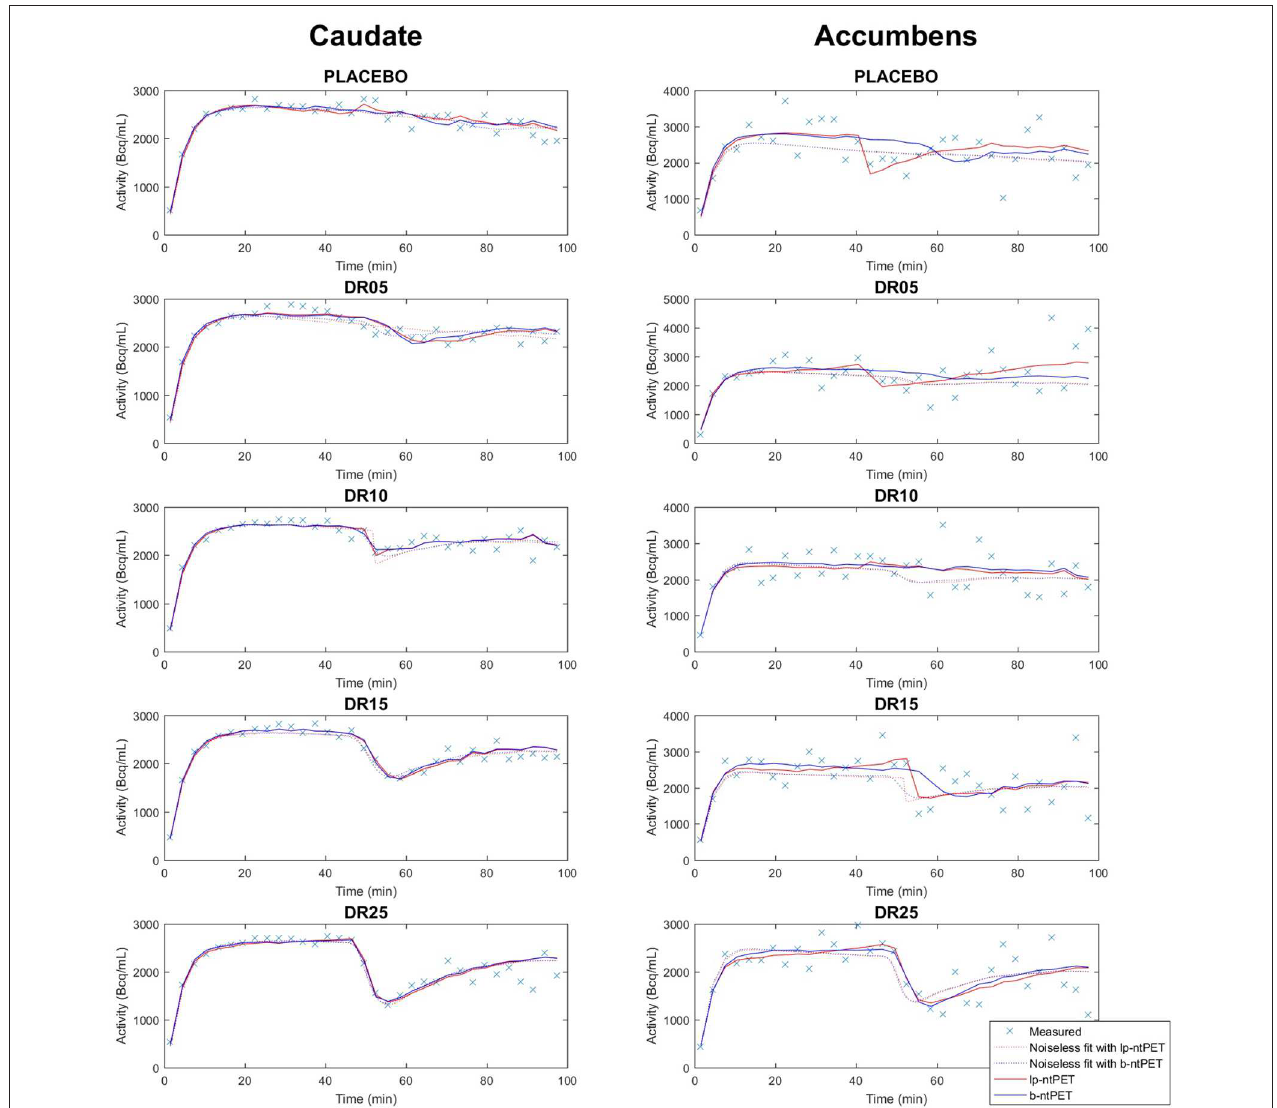
FIGURE 6 | Example of simulated TACs and fitted curves obtained with lp-ntPET (red) and b-ntPET (blue). The fitted curves on the mean TACs over all subjects (here labeled noiseless fit) are also shown on this figure for both methods, as reference. (Left) , caudate; (Right) ,